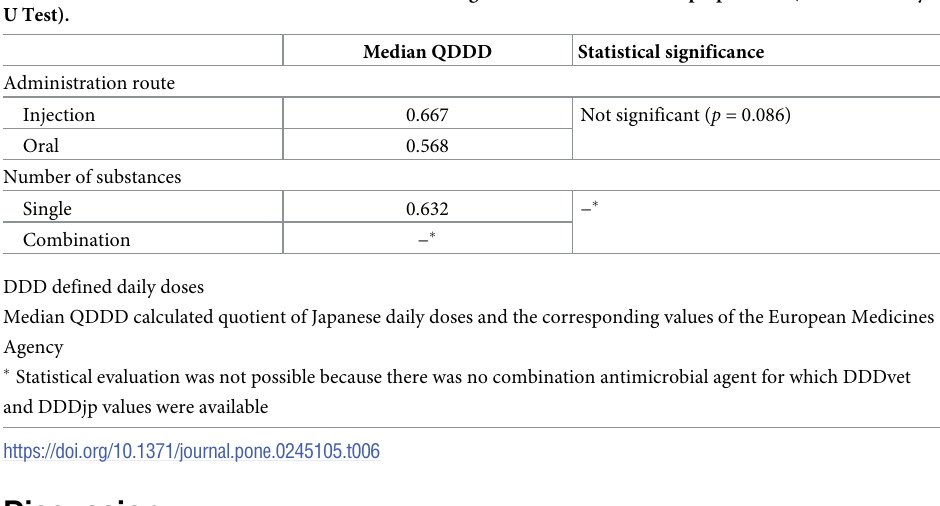
Table 6. Statistical evaluation of calculated quotients QDDD of antimicrobial agents for use in cattle in Japan in relation to administration route and number of active ingredients contained in the preparation (Mann-Whitney U Test).